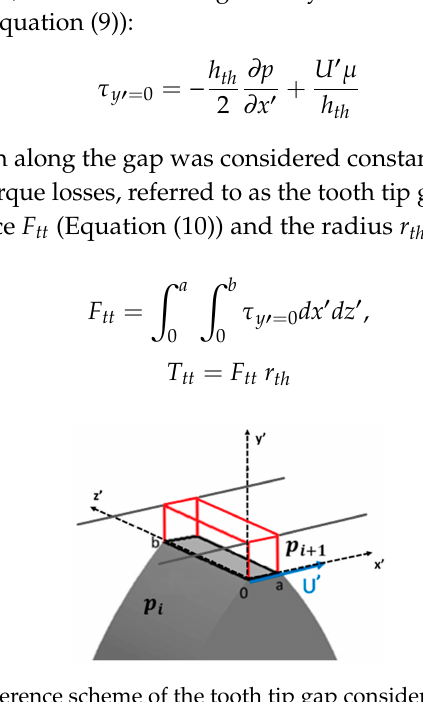
Figure 3. Reference scheme of the tooth tip gap considered in the model.